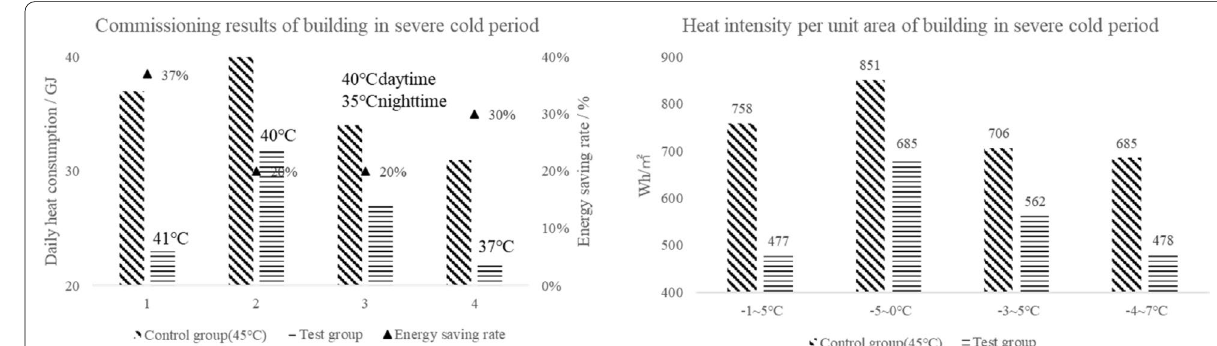
Fig. 7 Debugging results of typical buildings during a severe cold period